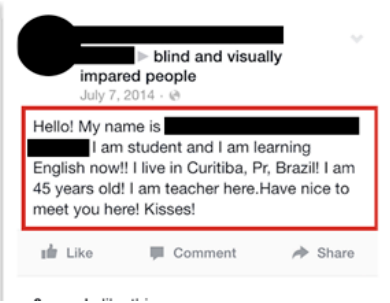
Figure 2. Student A presenting themselves to the “Blind and Visually Impaired People” Facebook group. Retrieved from [44] with permission.